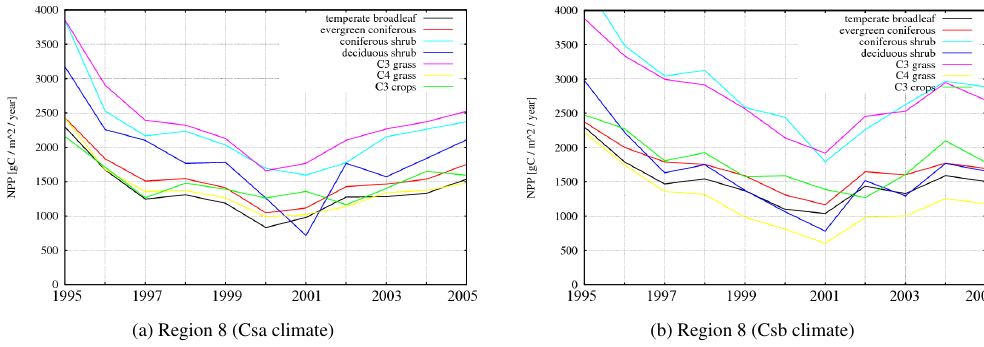
Fig. 13. Net primary productivity [ gCm − 2 a − 1 FM] variations in evaluation region 8 in the period 1995 to Figure 13. Net primary productivity [gCm − 2 a − 1 FM] variations in evaluation region 8 in the period 1995 to 2005. 2005 these regions ranges between 700 and 1500 gC m − 2 a − 1 FM (regions 12–15, not